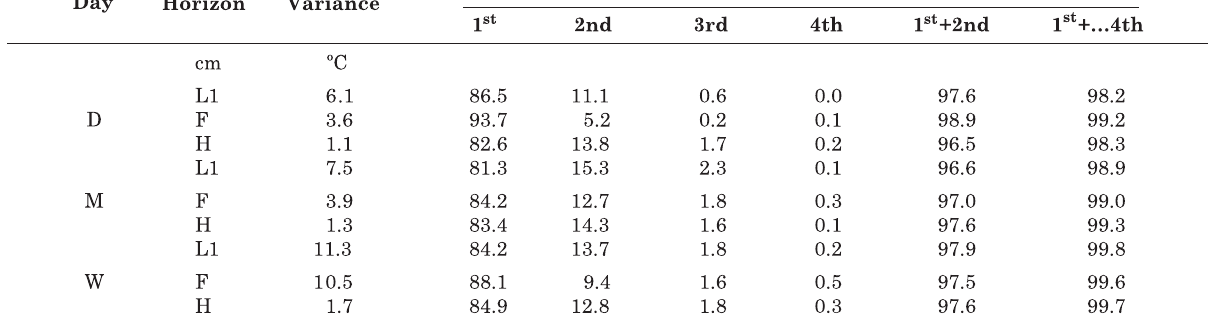
Table 3. Total variance of temperature in L, F and H litter sub-layers in a pine-forested Haplic Podzol and the percentage accounted for by the first four Fourier harmonics on days D (dry soil), M (moist soil) and W (wet soil)